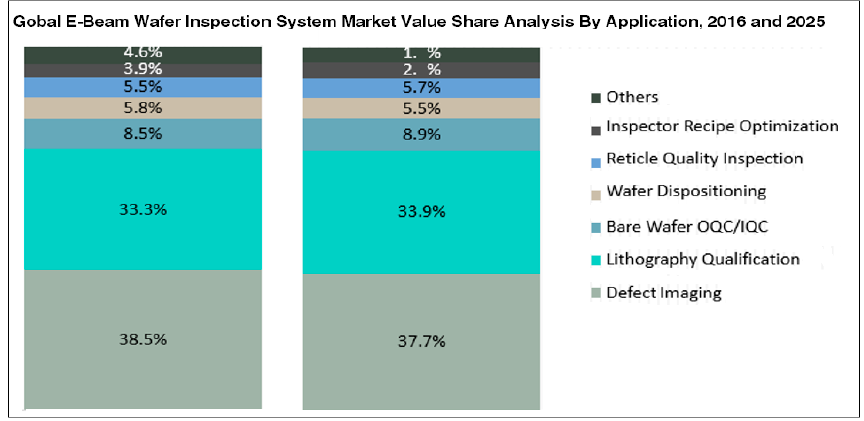
Figure 29. Global share analysis.